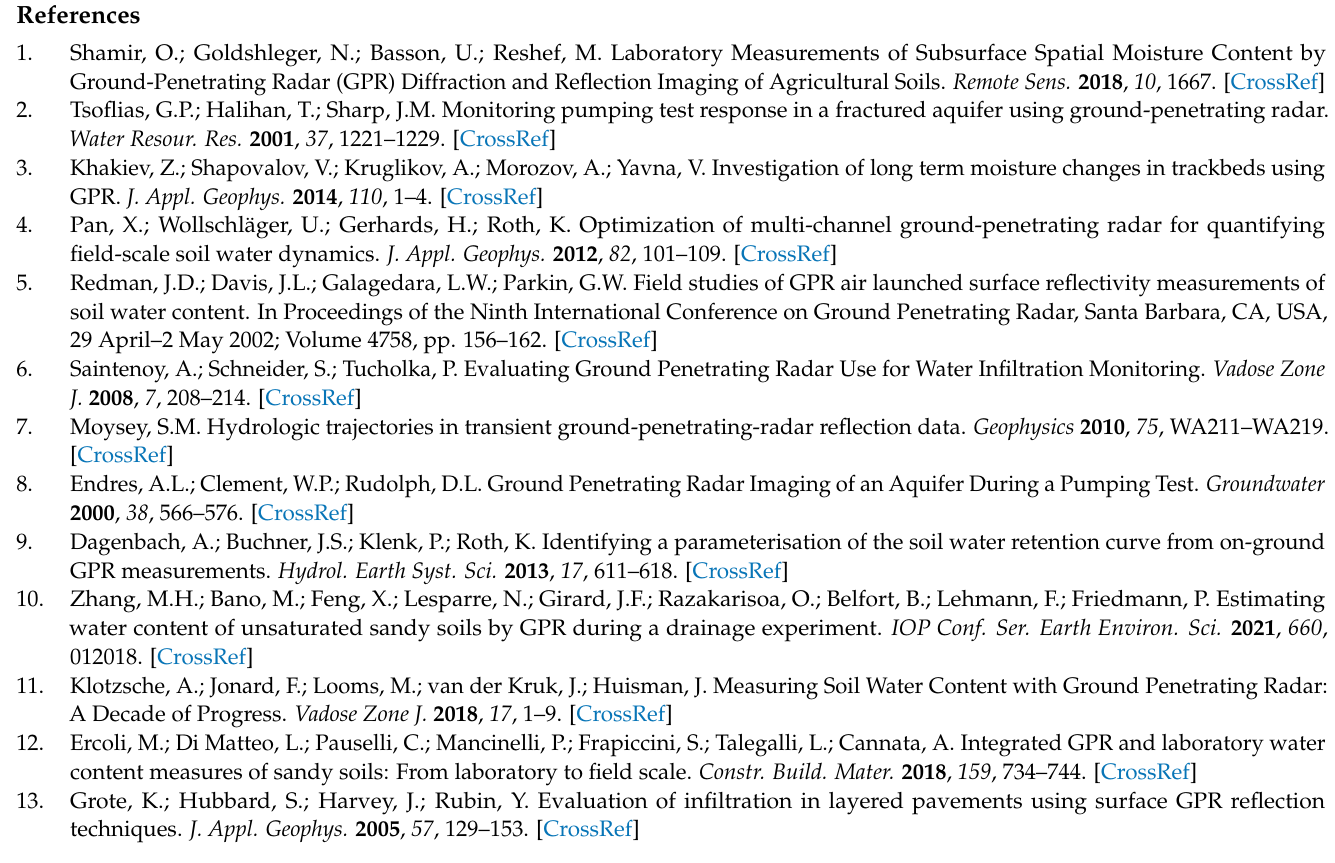
Figure A1. Distribution of optimal moisture values among sands from 50 different quarries.